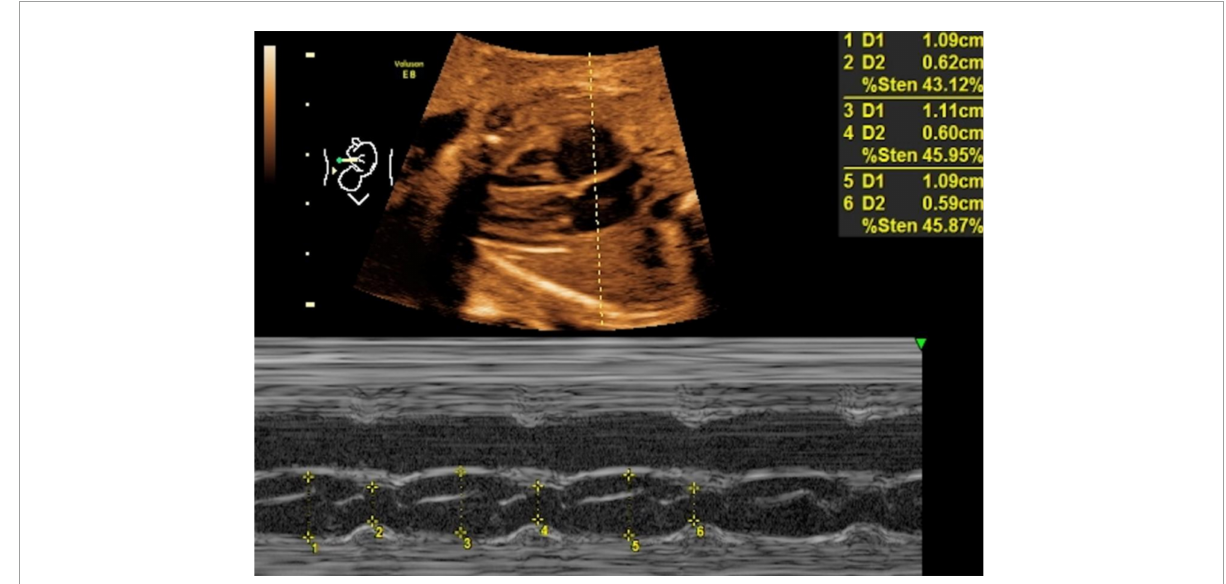
FIGURE2 LASF in control fetuses at gestational age 26 weeks + 3 days. LASF, left atrial shortening fraction.